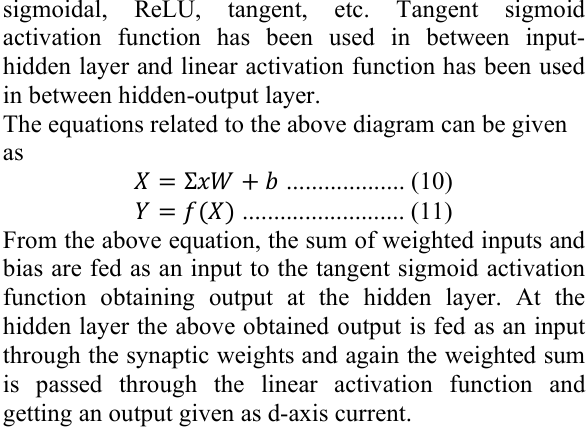
Figure 7. Internal Circuit of ANN